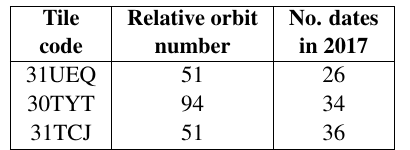
Table 1. Properties of the Sentinel-2 tiles used in the study A temporal gap-filling was applied to the Sentinel-2 images in order to replace cloudy pixels with an interpolated value based on the nearest cloud-free pixels of the temporal time series (Inglada, 2016). The time series were then resampled at 10-m spatial resolution with a 10-day time step common to all